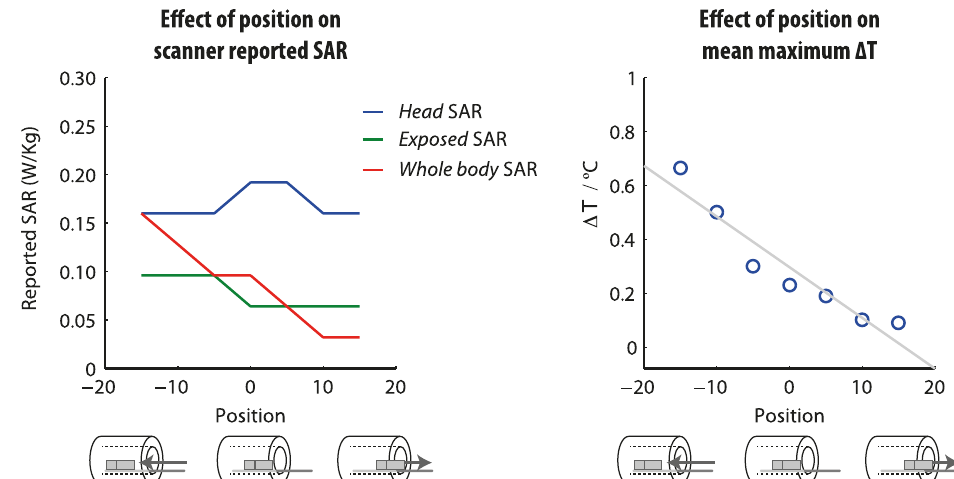
Fig 7. The effect of phantom position relative to the body-transmit coil on electrode-tip temperature increase. In contrast to the head-transmit coil, which moved with the patient table, the body-transmit coil is embedded at a fixed position in the scanner bore. By displacing the patient table we were able to systematically alter the position of the DBS circuit with respect to the body-transmit coil, as illustrated beneath the